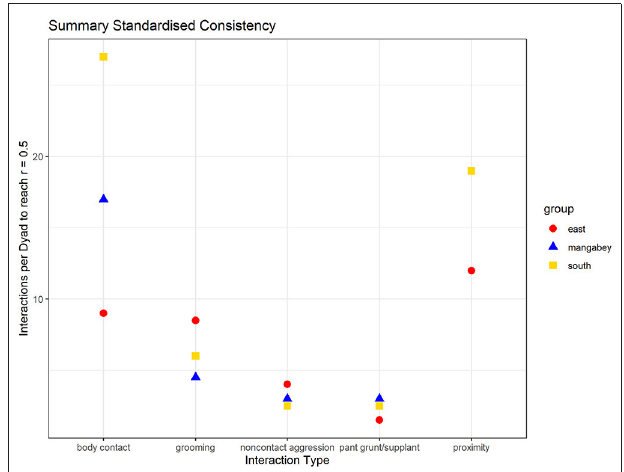
FIGURE 9 | Summary of the mean number of interactions needed per dyad to reach correlations between halves of r s = 0.5 (mangabeys: blue triangles, East: red points, South: golden